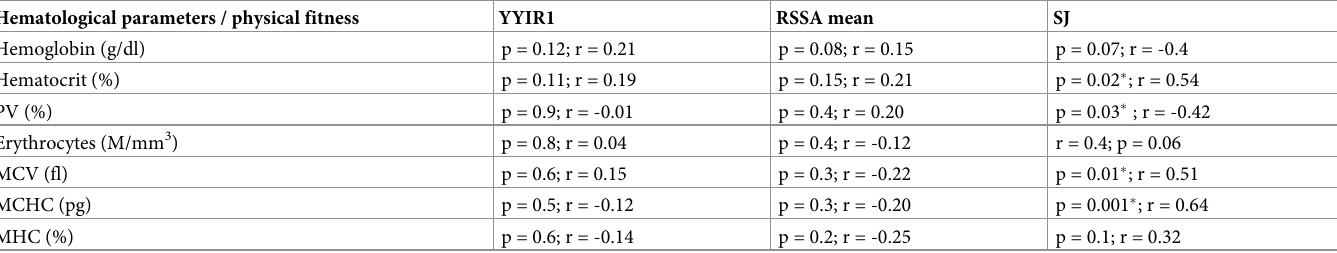
Table 5. Relationships (Pearson correlation coefficient) between PV, percentage changes of hematological parameters and percentage change of physical fitness. Hematological parameters / physical fitness YYIR1 RSSA mean SJ Hemoglobin (g/dl) p = 0.12; r = 0.21